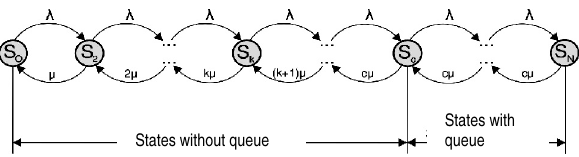
Fig 3 . Graph of states for queuing system M/M/c/FIFO/N Symbol λ or k μ ; k= 1 ,....,c , which stands for